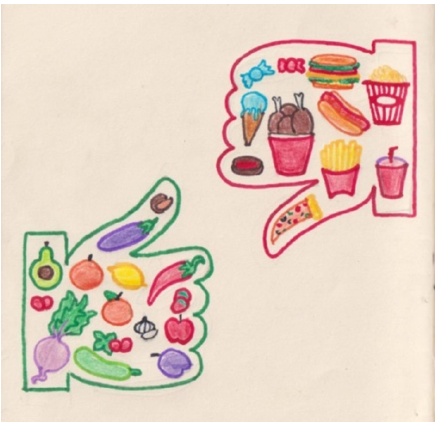
Figure 1. Rimsha’s photodiary: representation of the good and the bad food.